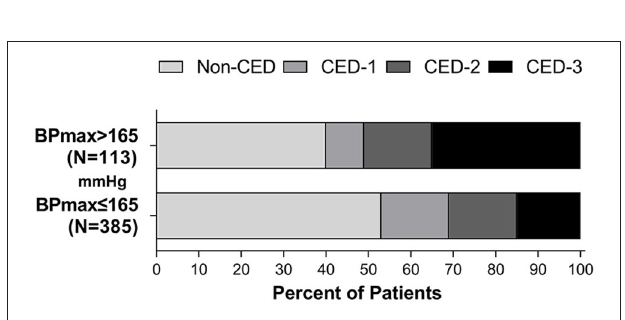
FIGURE 3 | Distribution of CED in patients with a SBP max of ≤ 165mm Hg and > 165 mmHg during the first 24h after